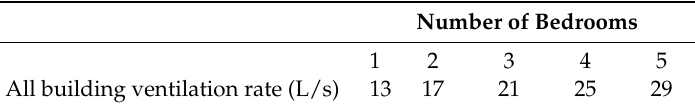
Table 6. Building ventilation rates